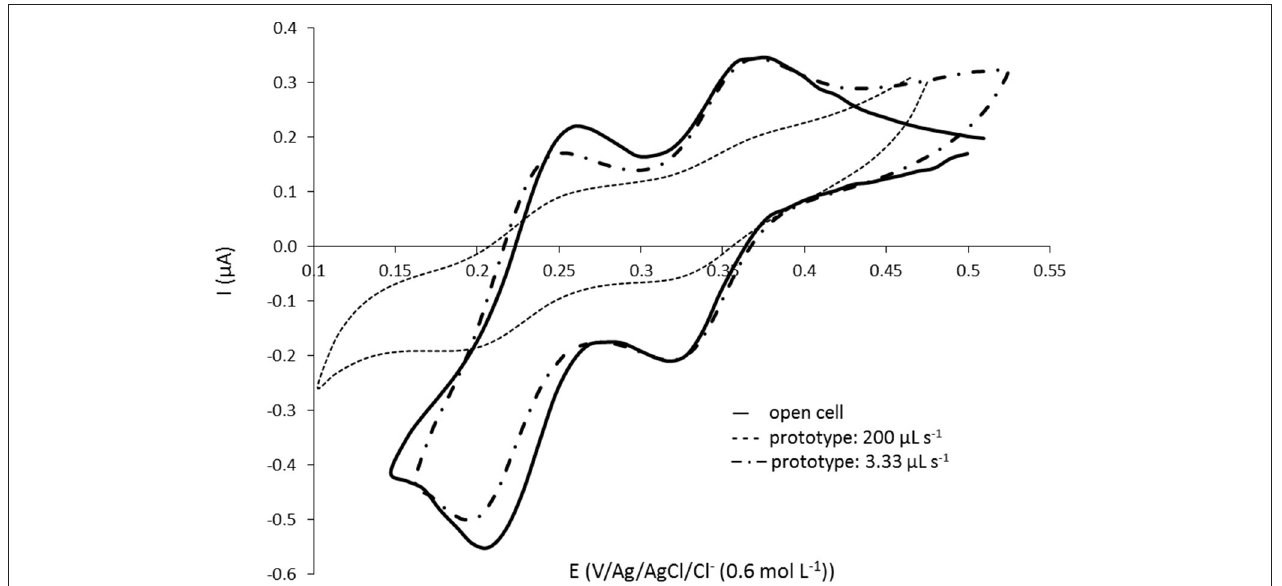
FIGURE 3 | Cyclic voltammograms at 100mV s − 1 on gold homemade working electrode (Ø = 1mm) for [Si(OH) 4 ] = 101.1 µ mol L − 1 in NaCl solution at 34.5g L − 1 . Comparison of signals obtained with (—) the open cell and with the prototype on Figure 1 for the fractions giving the highest signal obtained at flow rate (- - -) 200 µ L s − 1 (50 µ L transferred) and at (– · –) 3.33 µ L s − 1 (100 µ L transferred).